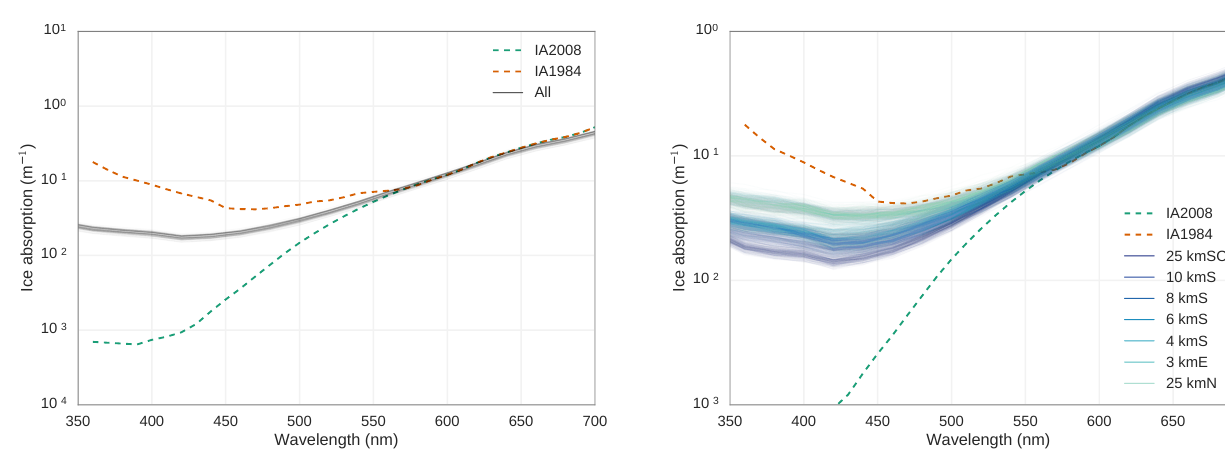
Figure 6. Samples (gray) of the posterior distribution of the ice absorption estimated by the BAY method on the 70 homogeneous zones selected in the 56 radiance profiles measured around Concor- dia.